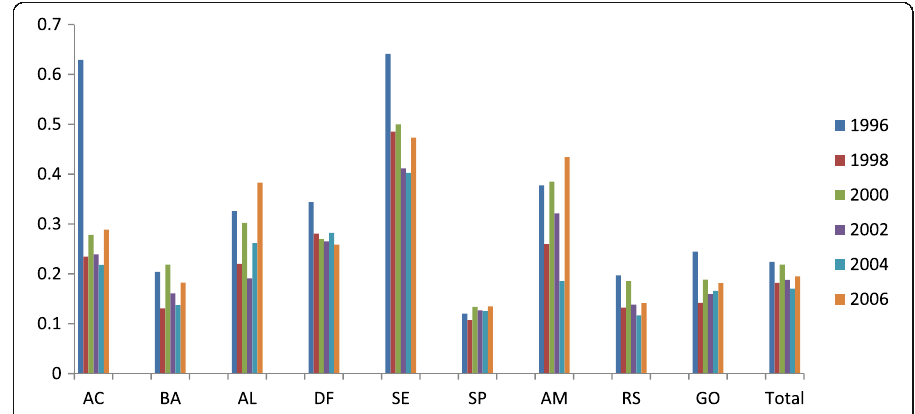
Fig. 1 Inspection intensity indicator by year for selected